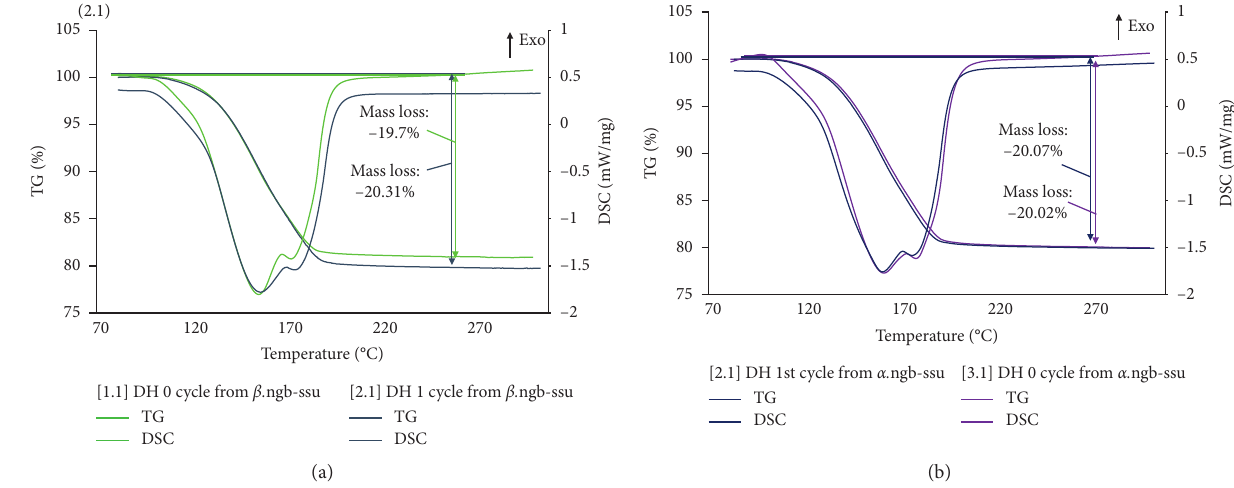
Figure 11: STA for the generated DH before and after the first hydration cycle from (a) β -HH and (b) α -HH.